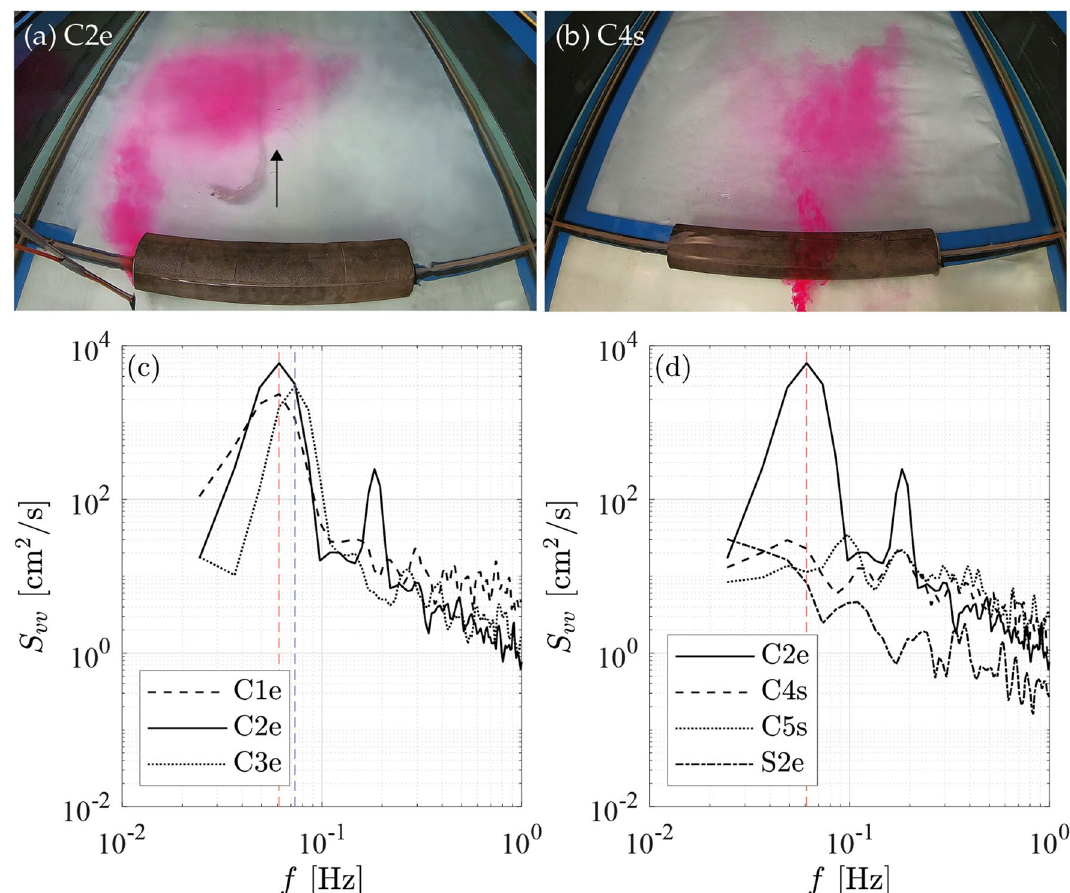
Figure 4. ( a ) and ( b ) Photos of C2e with 50-cm long emergent log and C4s with 50-cm long submerged log with tracer injected upstream of log to illustrate the presence ( a ) and absence ( b ) of a von-Kármán vortex street. When present, the vortex street was unsteady, with vortices forming and shedding from either end of the log in a regular alternating pattern. ( a ) illustrates the formation of a single vortex on the left-side of the log, and subsequently a vortex forms on the right-hand side; ( c ) and ( d ) Power spectra of lateral flow velocity component measured at log center at maximum k t